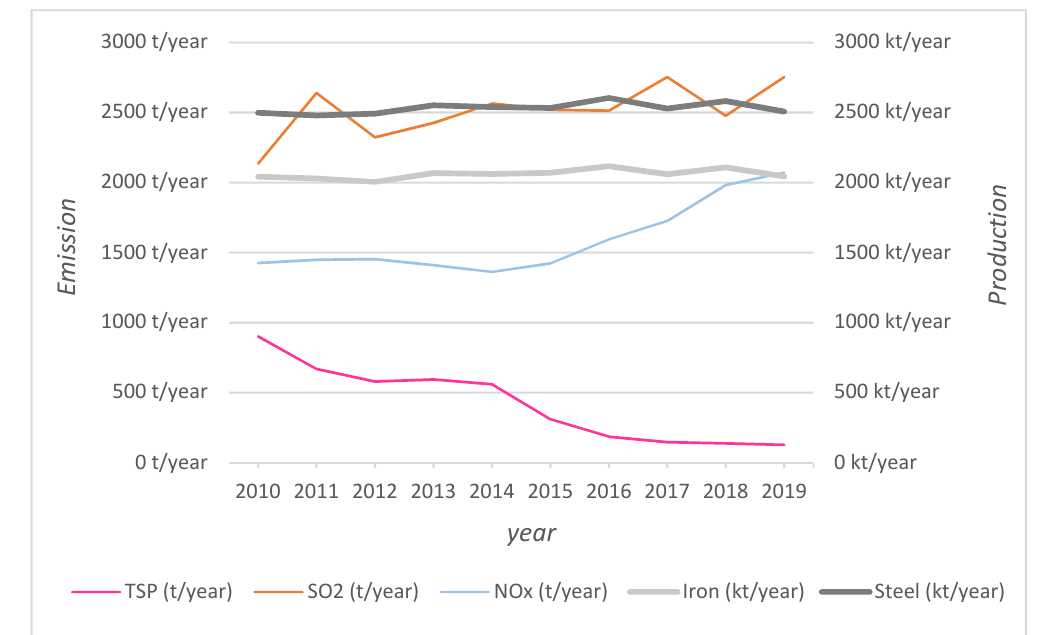
Figure 2 . Emissions and production of the Třinec Iron and Steel Works. Figure 2. Emissions and production of the Tˇrinec Iron and Steel